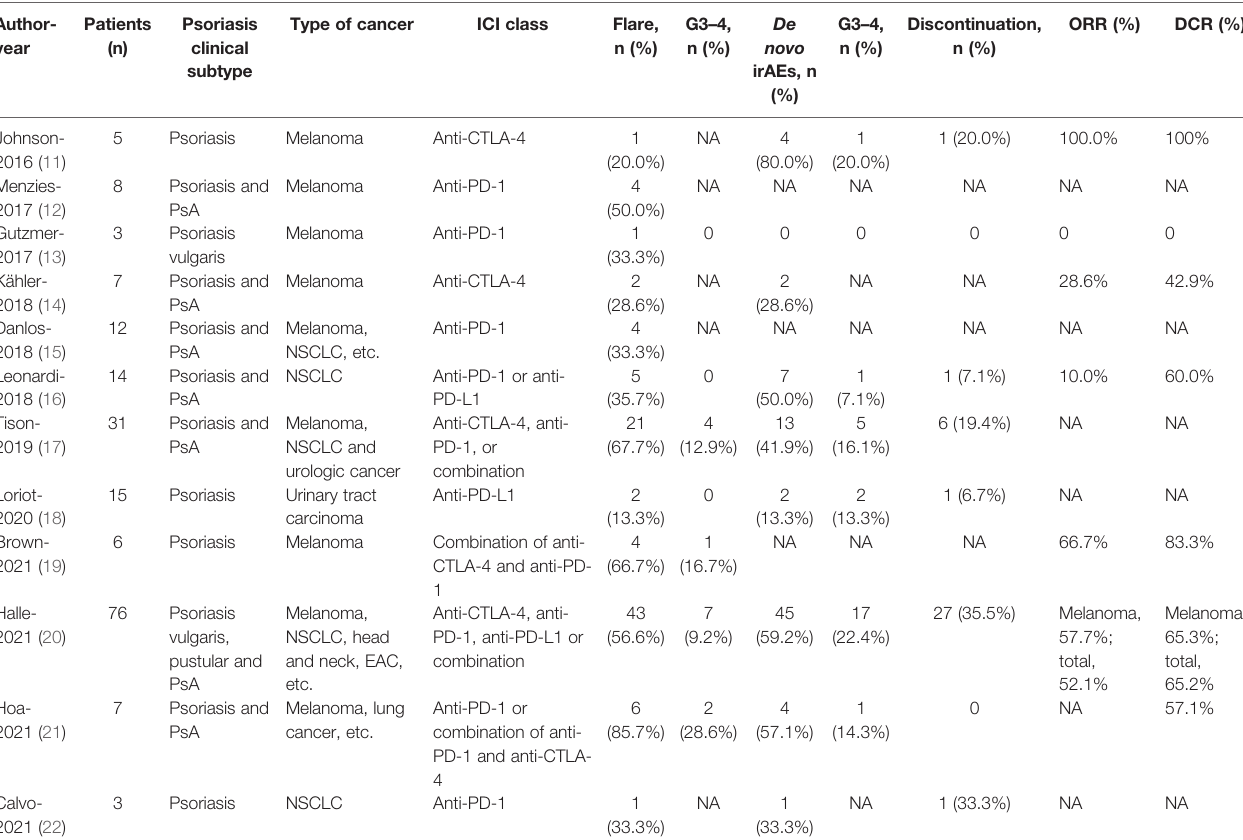
TABLE 1 | Basic characteristics of the included